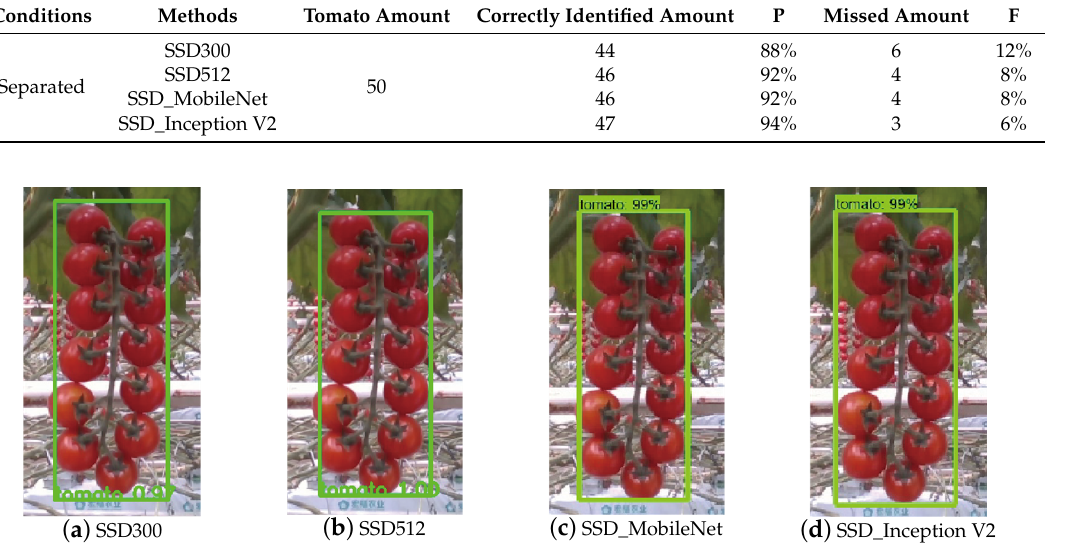
Figure 5. The detection results of separated cherry tomatoes. ( a ) the result of SSD300 model, ( b ) the result of SSD512 model, ( c ) the result of SSD_MobileNet model and ( d ) the result of SSD_Inception